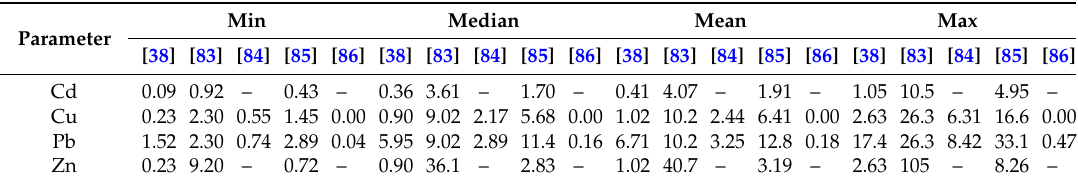
Table 8. Variations of the traffic related heavy metal emissions (t/yr) by de-icing salts with different contents (cf. [38,83–86]) in Germany